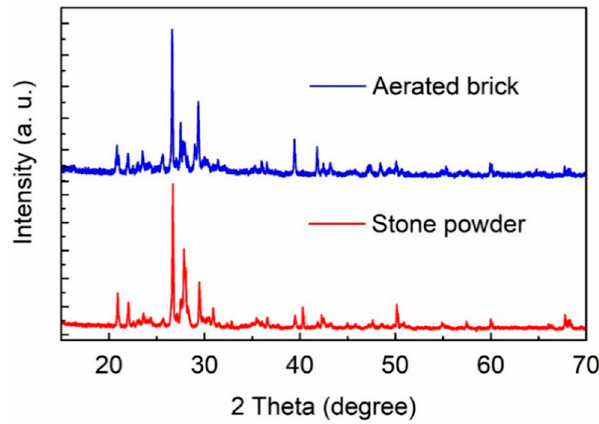
Figure 1. XRD patterns of the waste stone powder (lower red curve) and the aerated brick (upper blue curve).